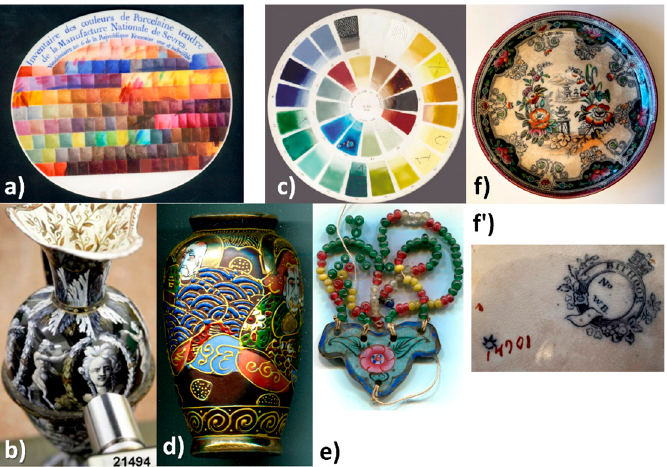
Figure 2. Selection of objects representative of the variety of colored decorations obtained with